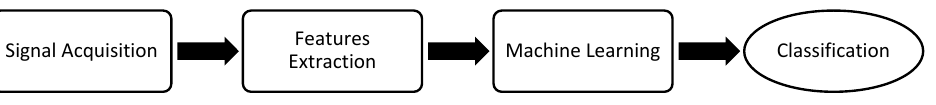
Figure 1. Block diagram for the approach in schizophrenia classi fi cation.